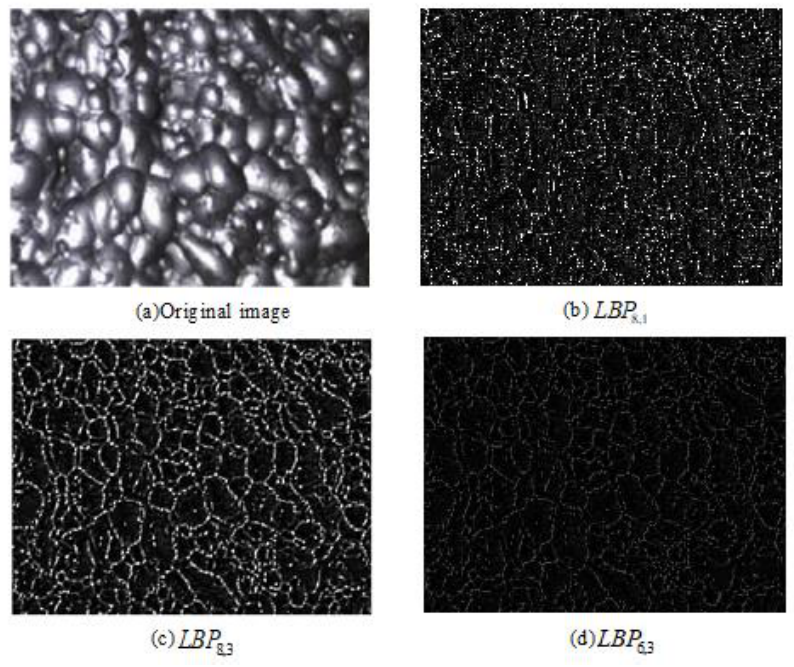
Figure 10. The processing effect of different values.